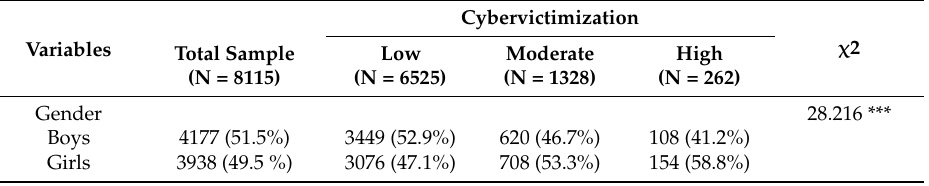
Table 1. Sociodemographic variables.